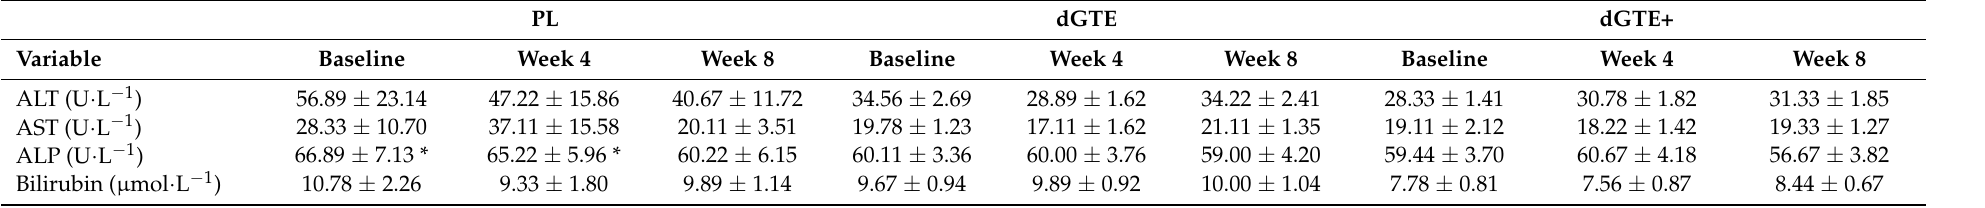
Table 9. Mean serum liver function markers at baseline (week 0), week 4 and 8 between intervention groups.